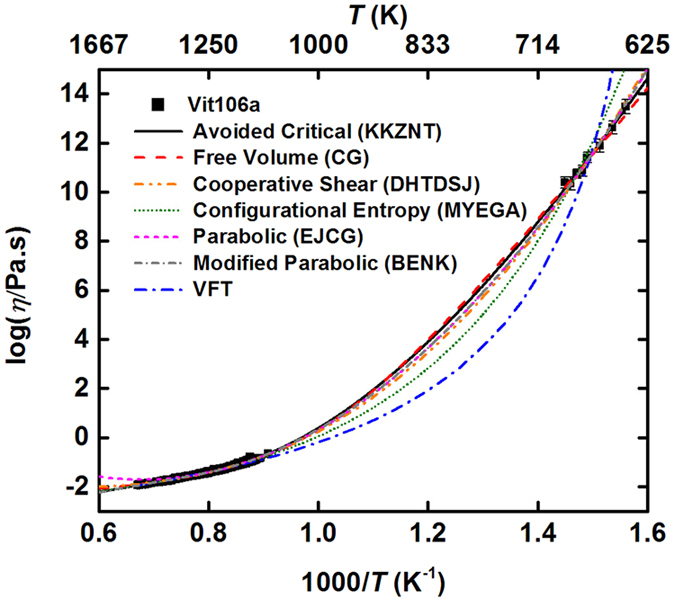
Comparison of the fits to the Vit 106a data for the expressions listed in Table 1.The fit parameters can be found in Supplementary Table 1. Error bars are one s.d.